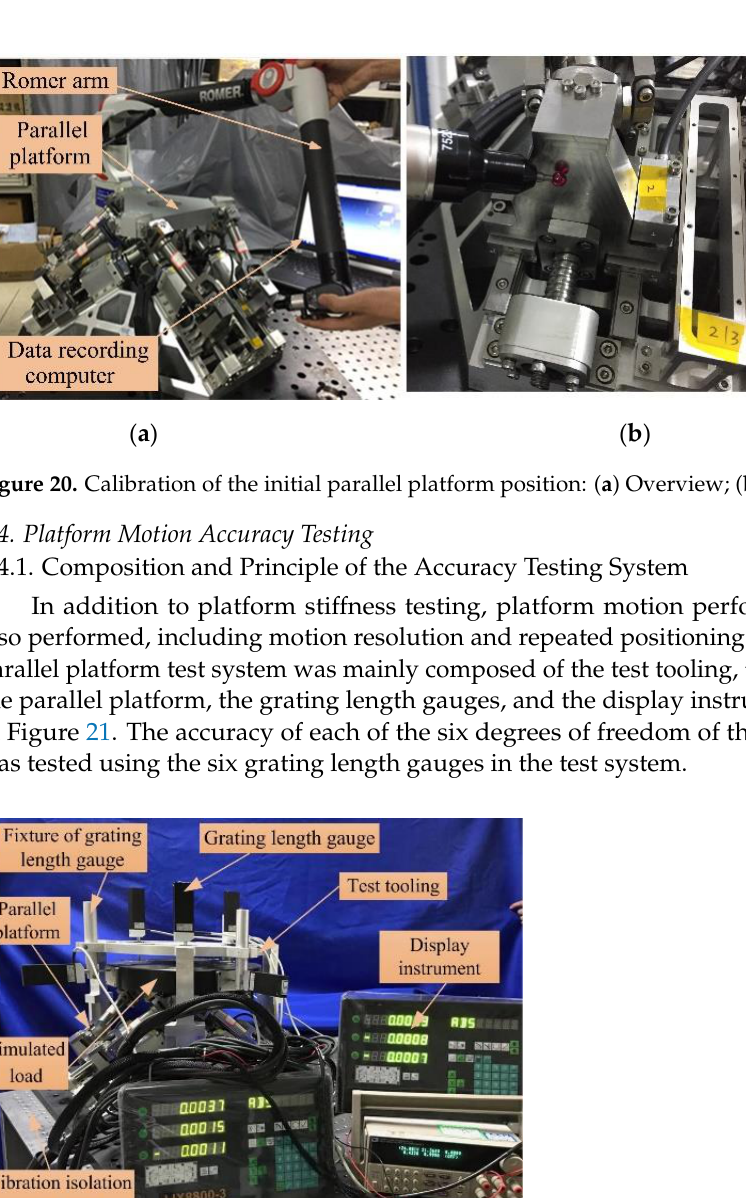
Figure 22. Definition of the coordinate system for the parallel platform and layout of the grating length gauges. When the platform target pose was given, the displacement of the inclined block could be calculated using the inverse kinematics algorithm. Then, using the ball screw lead, the reduction ratio of the harmonic reducer, the step length of the stepping motor,